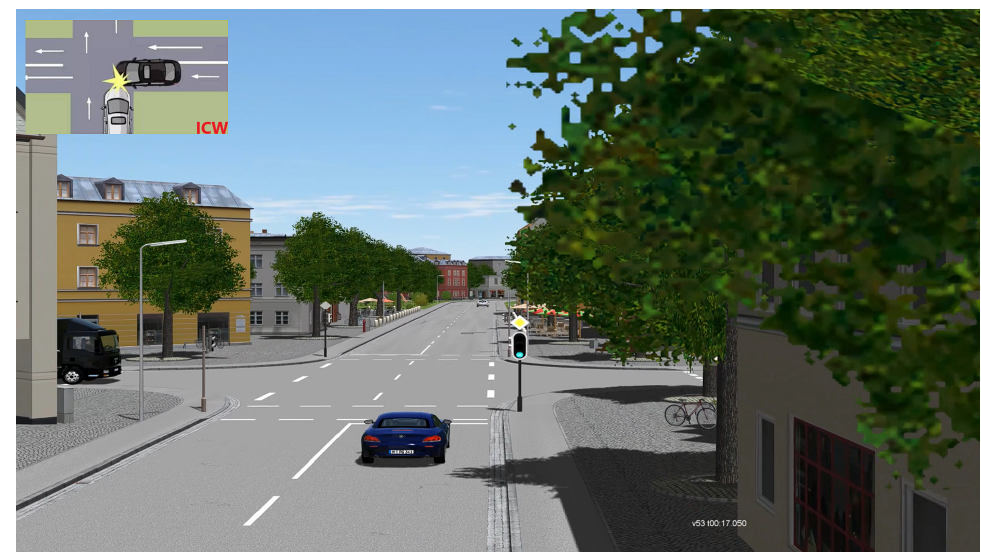
Figure 4. Intersection Collision Warning (ICW) function test.